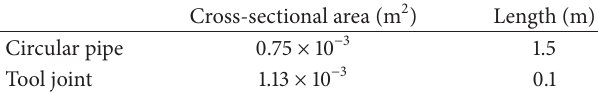
Table 2: Dimensions of simulated drillstring.